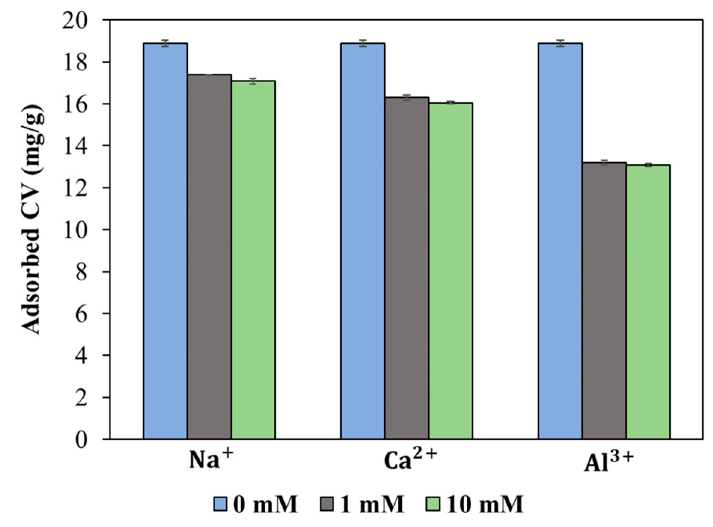
Figure 5. Effect of competing cations on CV adsorption on BC-PKS (initial concentration: 400 mg/L; volume: 30 mL; adsorbent dosage: 0.5 g; reaction time: 24 h; temperature: 25 ° C).